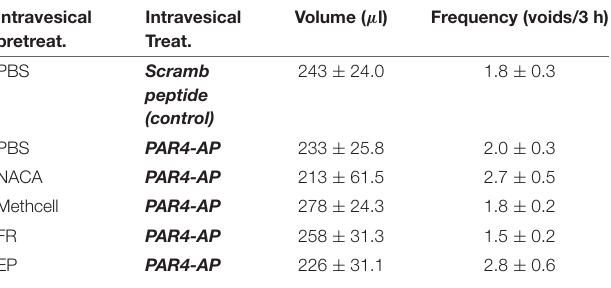
TABLE 2 | Effect of intravesical treatments on awake (VSOP) micturition parameters. Mean ± SEM. N = 6 per group. Intravesical pretreat.